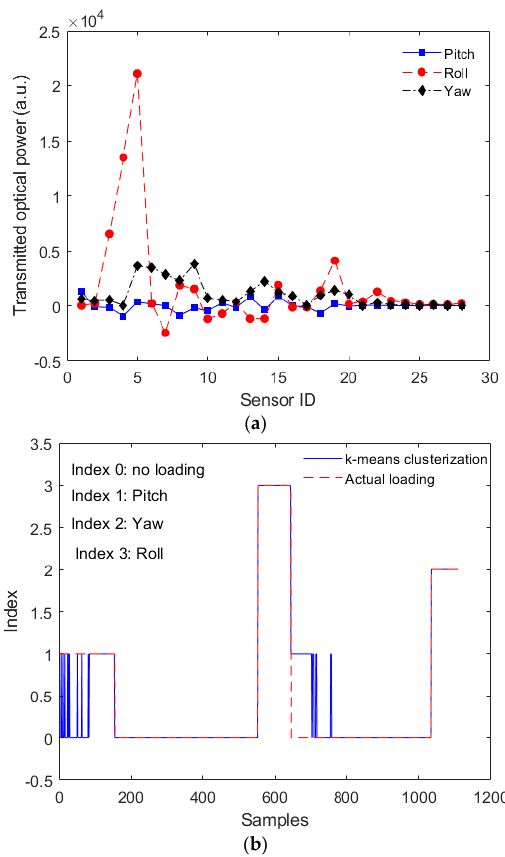
Figure 7. ( a ) Transmitted optical power distribution along the sensor system (considering all 30 sensors) for different loading conditions. ( b ) Clustering results of the sensor responses using k-means. Figure also shows the actual mechanical loading applied for each